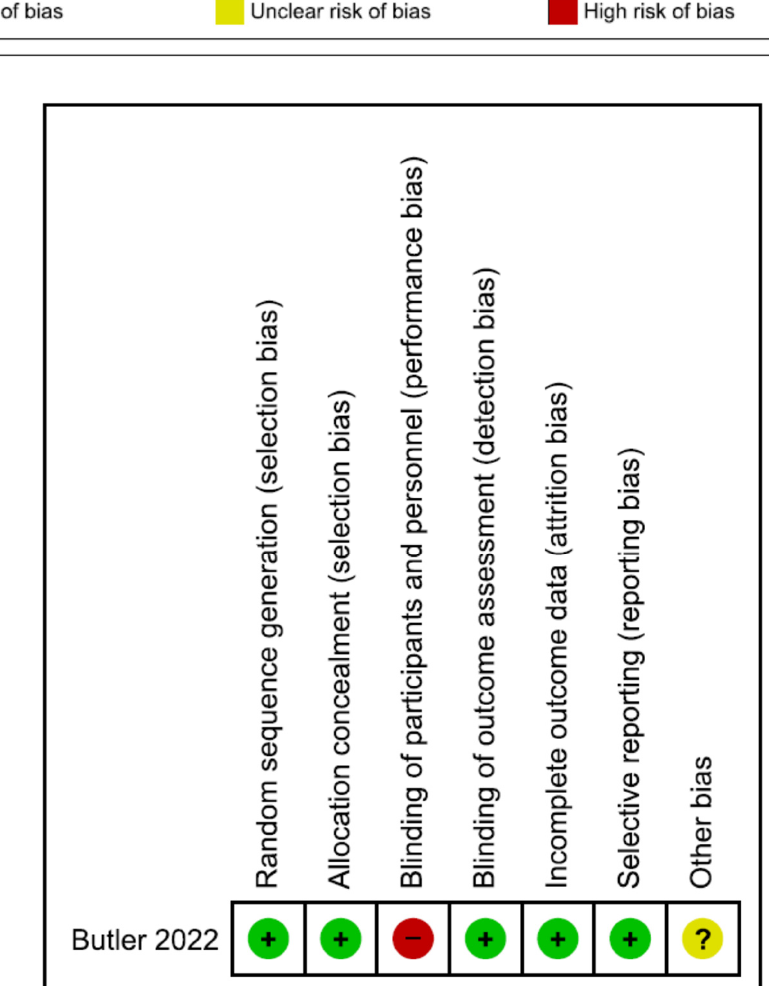
Figure 2. Risk of bias of one randomized controlled trial.